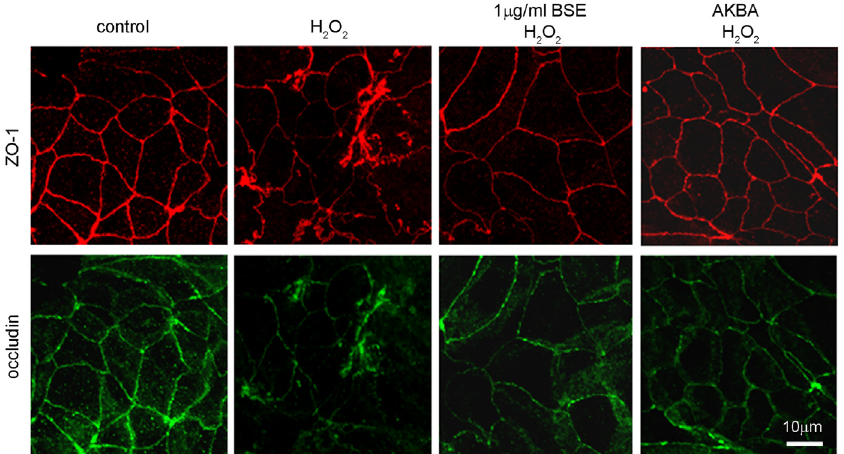
Fig 5. BSE and AKBA ameliorate alterations following exposure to H 2 O 2 occludin and zonula occludens (ZO1) TJ proteins in Caco-2 cell monolayers. Double immunostaining showing the distribution of ZO-1 (red) and occludin (green). Images were collected by confocal laser-scanning microscope and are representative of 3 independent experiments. Scale bar = 10 μ